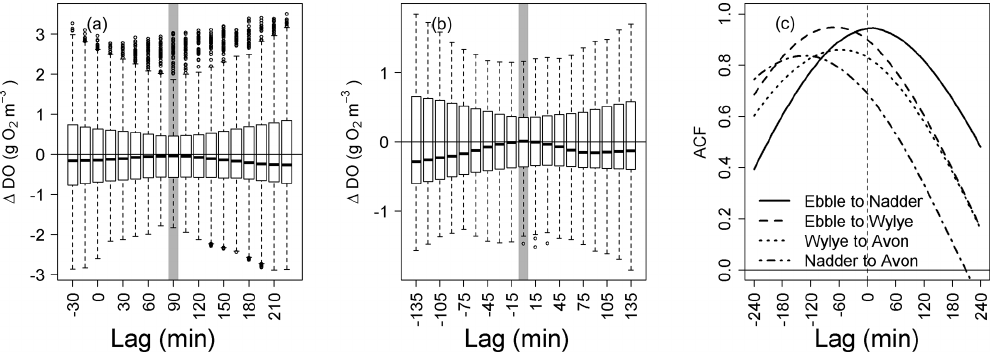
Figure 3. Analysis of lagged differences in DO between normalised DO time series. (a) Ebble and Wylye, (b) Ebble and Nadder (c) cross- correlations for four rivers for 5 to 20 May